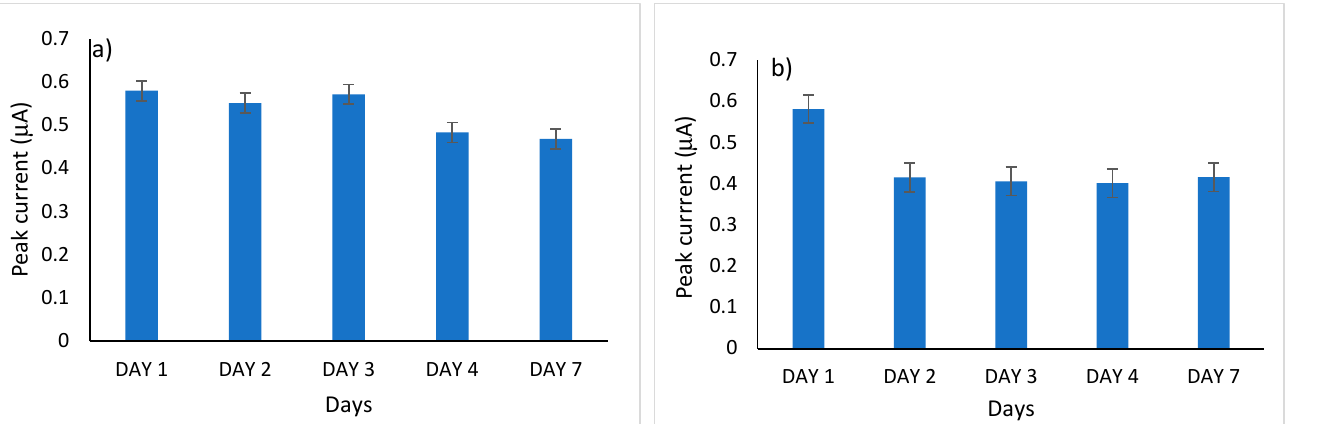
Table 4. Comparison between performances of other analytical methods and the proposed electro- chemical method.